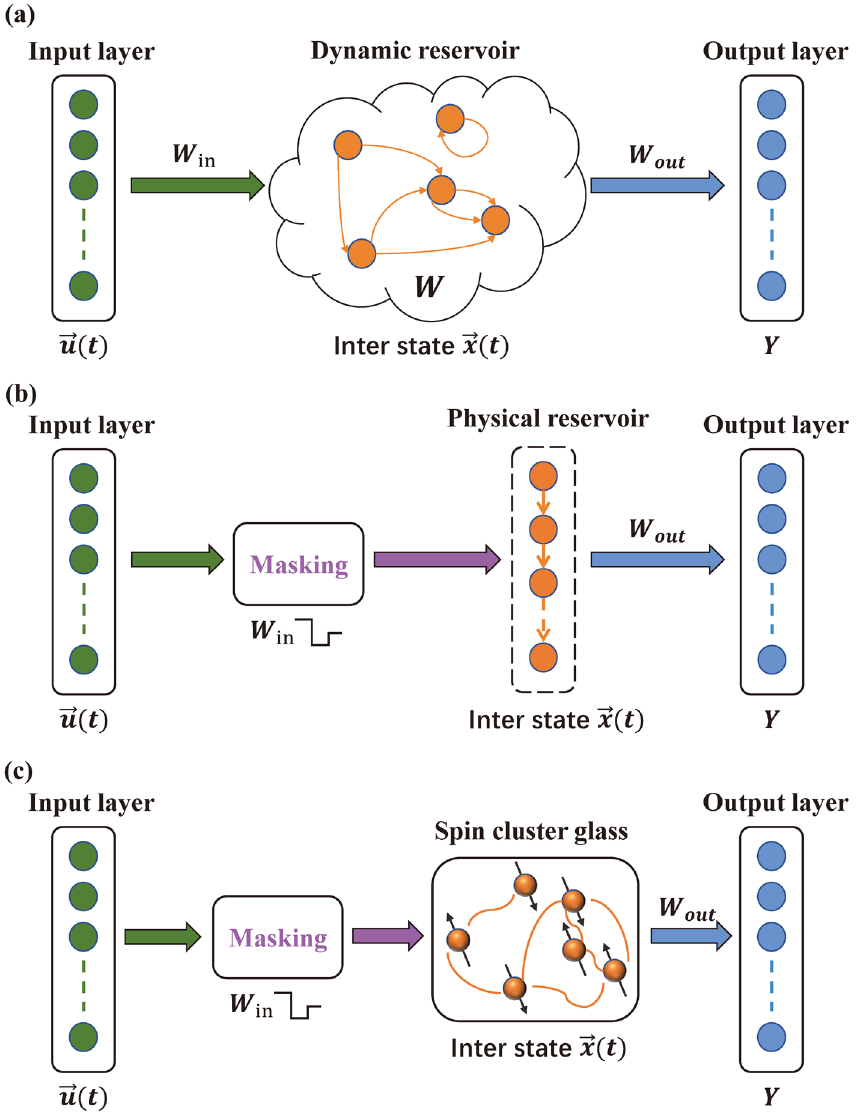
Figure 2. ( a ) Schematic of traditional reservoir computing. After receiving the input information, the reservoir state is dynamically updated internally. ( b ) Schematic of physical reservoir computing with time-multiplexing approach. The physical reservoir is completed by time multiplexing the physical system response. Each unit in the physical reservoir is equivalent to a sampling point. ( c ) Schematic of physical reservoir computing based on spin cluster glass. Connection of its internal nodes is determined by the complex interaction among spins of the